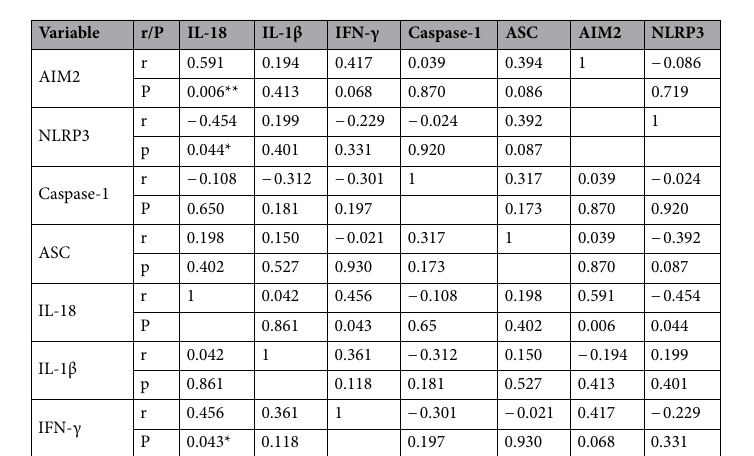
Figure 3. The description and differences of the expression levels (pg/ml) of inflammatory cytokines IL-18, IL-1β and IFN-γ in each experimental group. Serum IL-1β, IL-18, and IFN-γ mean values in healthy control, acute brucellosis and chronic brucellosis volunteers. Mean ± SD were presented in each group. *symbolize statistical differences of IL-18 and IFN-γ values between the healthy group and brucellosis group, respectively ** P < 0.01,* P < 0.05.